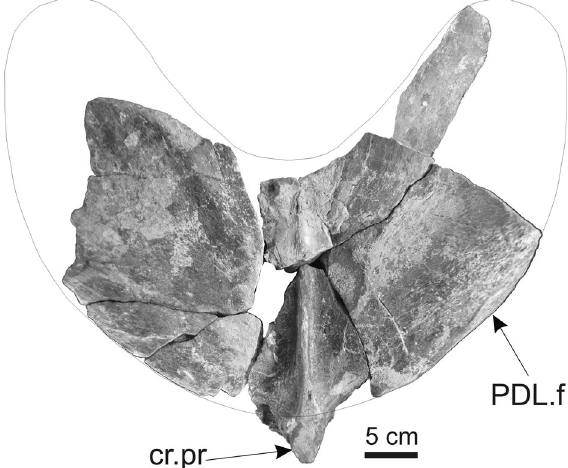
Fig. 5. Specimen Muz. PGI-NRI 1809.II.19, median dorsal plate in visceral view. Abbreviations: cr.pr, carinal process; PDL.f, contact face for the posterior dorsolateral plate.